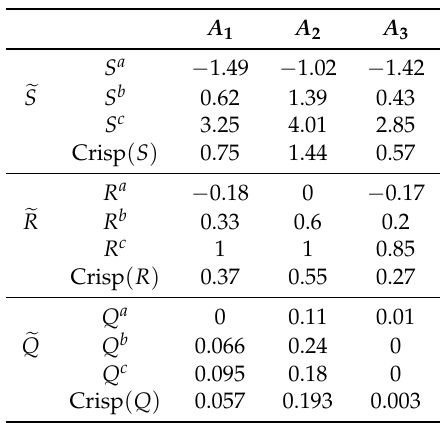
Table 11. Results by fuzzy VIKOR.